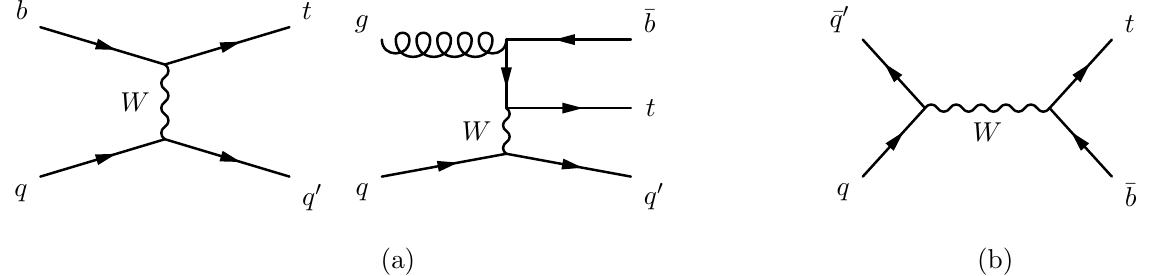
Figure 2. Representative leading-order Feynman diagrams for the production of a single top quark in (a) the t -channel and (b) the s